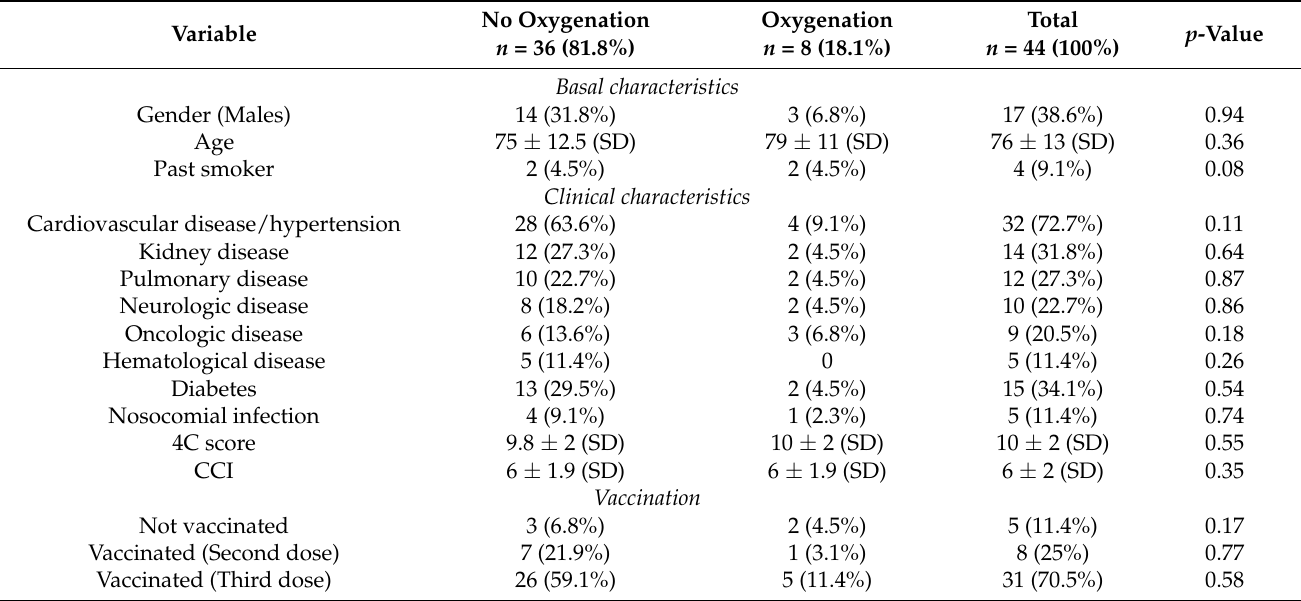
Table 4. Patients’ characteristics distributions between patients that need oxygen after molnupiravir start and patients without need of oxygen start.